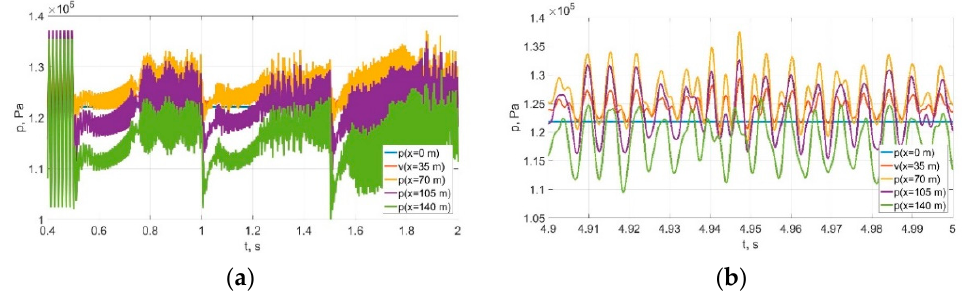
beginning of the simulation time; ( b ) the end of the simulation time. Figure 11. Pressure in the 2nd pipeline (L2) (Table 2) of the LNG transportation system: ( a ) the